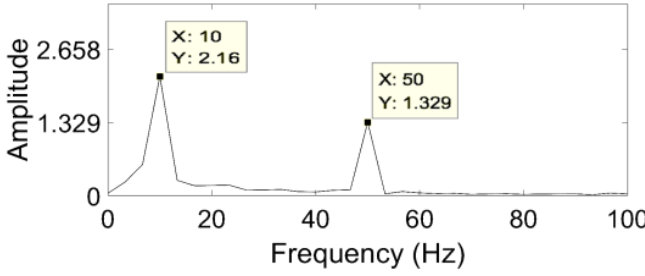
Figure 33. SCR = 1.07 in PI control system.